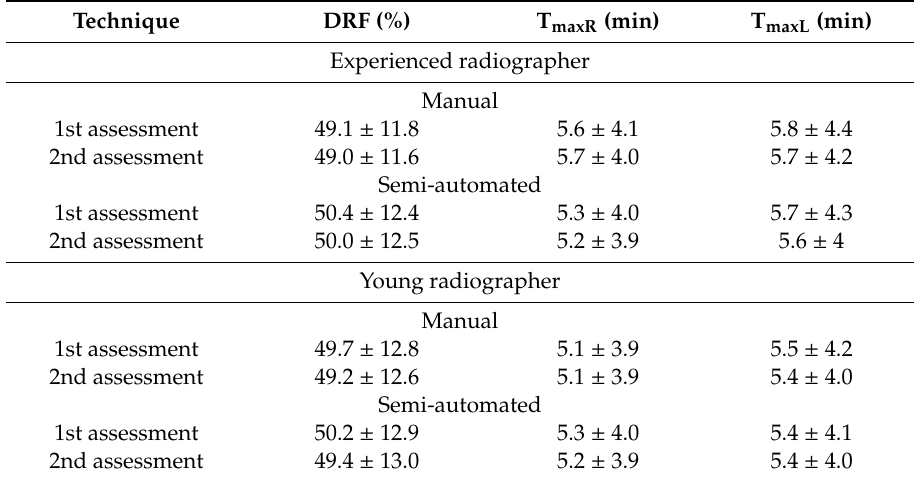
Table 2. Descriptive statistics (mean ± 1 SD) of the diuretic renography parameters of di ff erential renal function (DRF) and time to maximum counts (T max ) obtained from the two